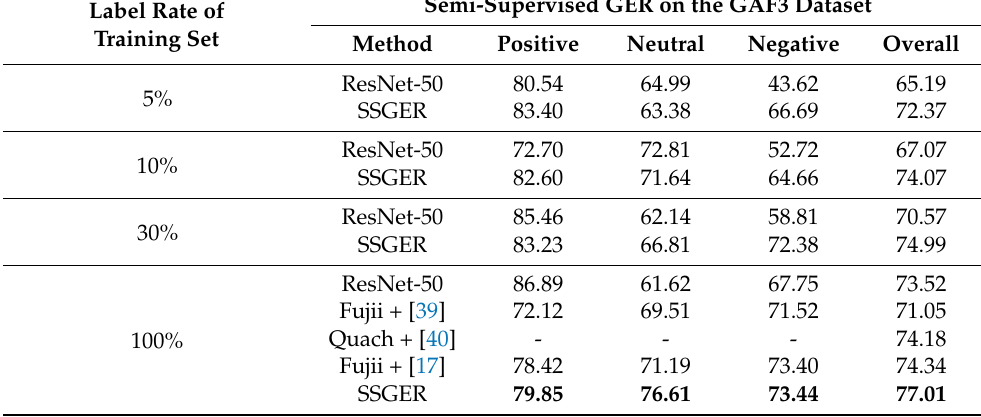
Table 3. Comparison of classification accuracy (in %) on the GAF3 dataset. The values in bold refer to the best result, and the symbol of “-” indicates the result was not reported in the paper of the compared method.